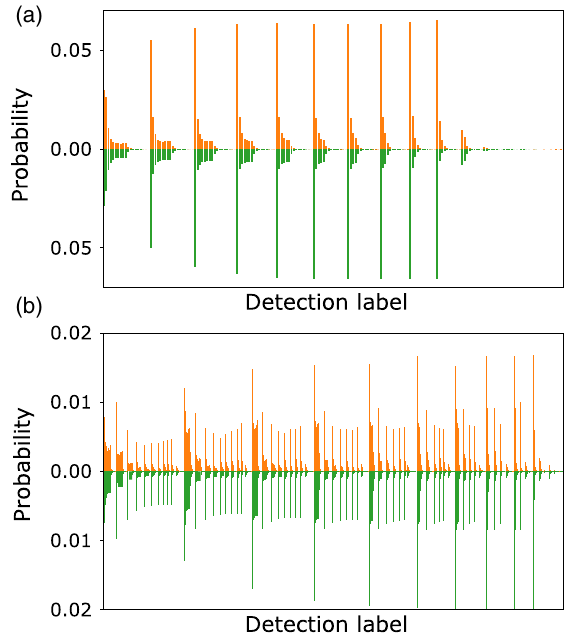
FIG. 5. Probability distribution for the twofold (a) and three- fold (b) detections with an input squeezing of λ ¼ 0 . 31 . Green bars show the theory values and orange bars the experimental data. The x -axis detection labels are sorted in ascending order from left to right, i.e., f½ 1 ; 1 (cid:3) ; ½ 1 ; 2 (cid:3) ; … ; ½ 19 ; 20 (cid:3) ; ½ 20 ; 20 (cid:3)g and f½ 1 ; 1 ; 1 (cid:3) ; ½ 1 ; 1 ; 2 (cid:3) ; … ; ½ 19 ; 20 ; 20 (cid:3) ; ½ 20 ; 20 ; 20 (cid:3)g ,